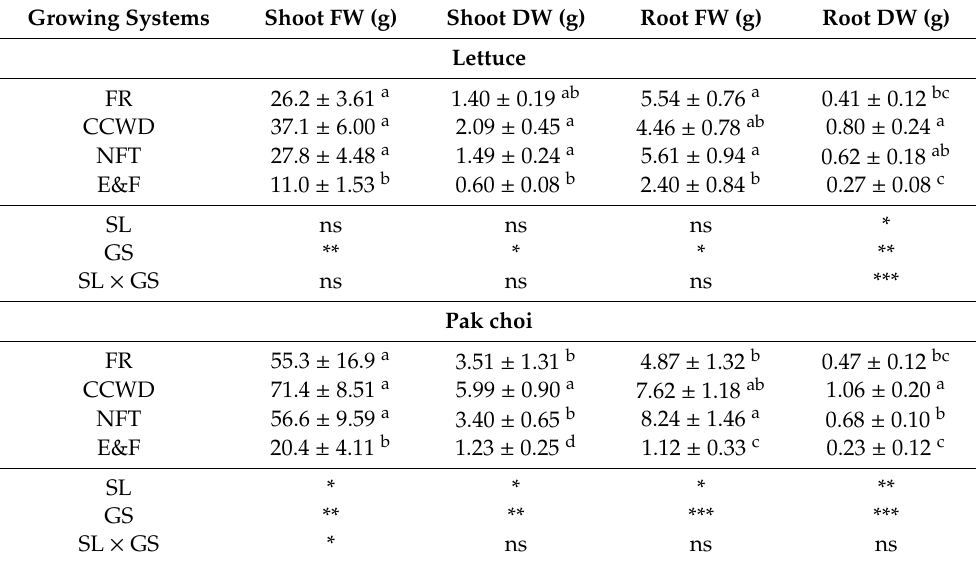
Table 4. Average shoot and root fresh weight (FW) and dry weight (DW) of lettuce and pak choi cultivated in di ff erent aquaponic growing